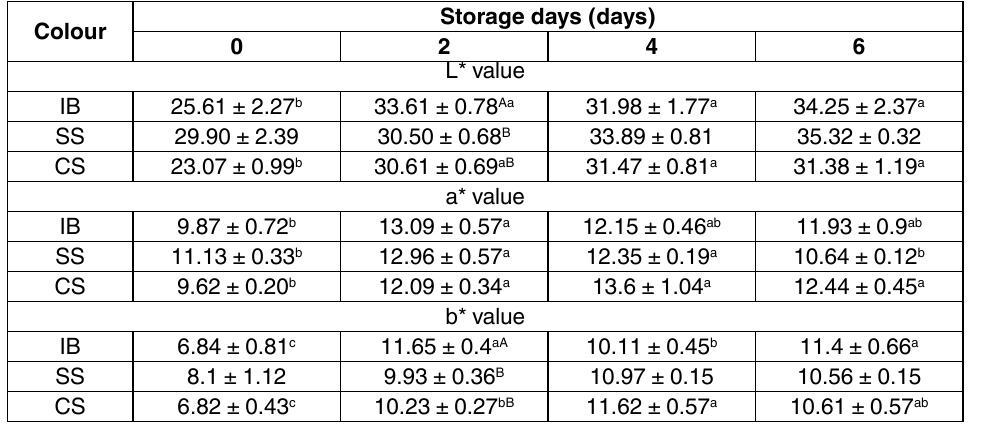
Table 1. Mean L* a* b* values of imperfectly bled (IB), scientifically slaughtered (SS) and cold slaughtered (CS) meat samples during storage (Mean±S.E.)